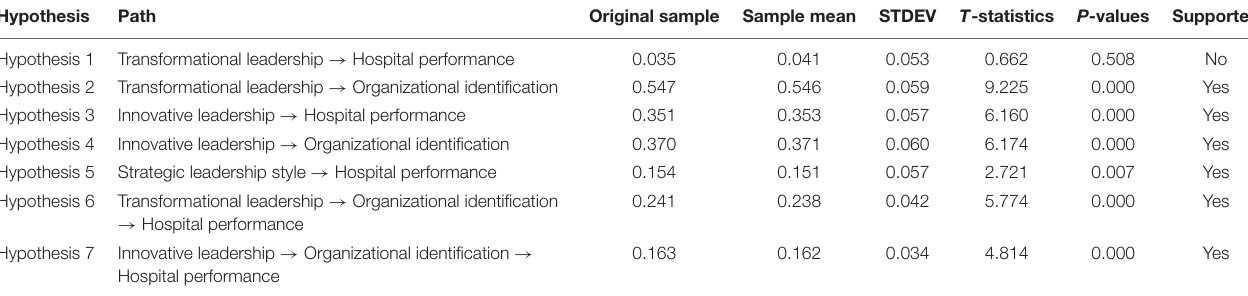
FIGURE 4 | Path analysis. TABLE 4 | Path